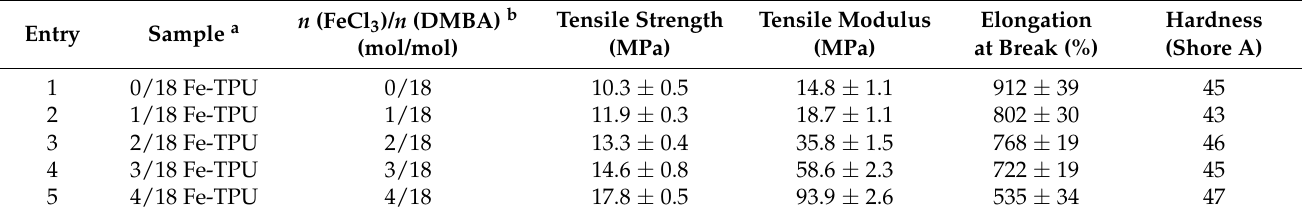
Table 2. Mechanical property of TPU reinforced with FeCl 3 .